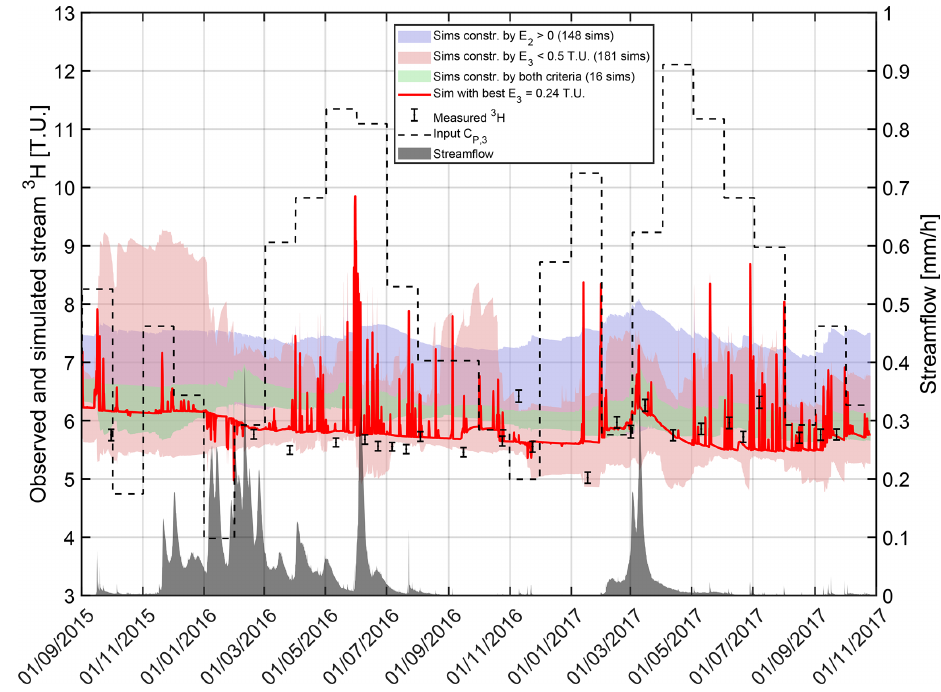
Figure 6. Simulations of stream concentrations in tritium compared to observations of and variability in precipitation.